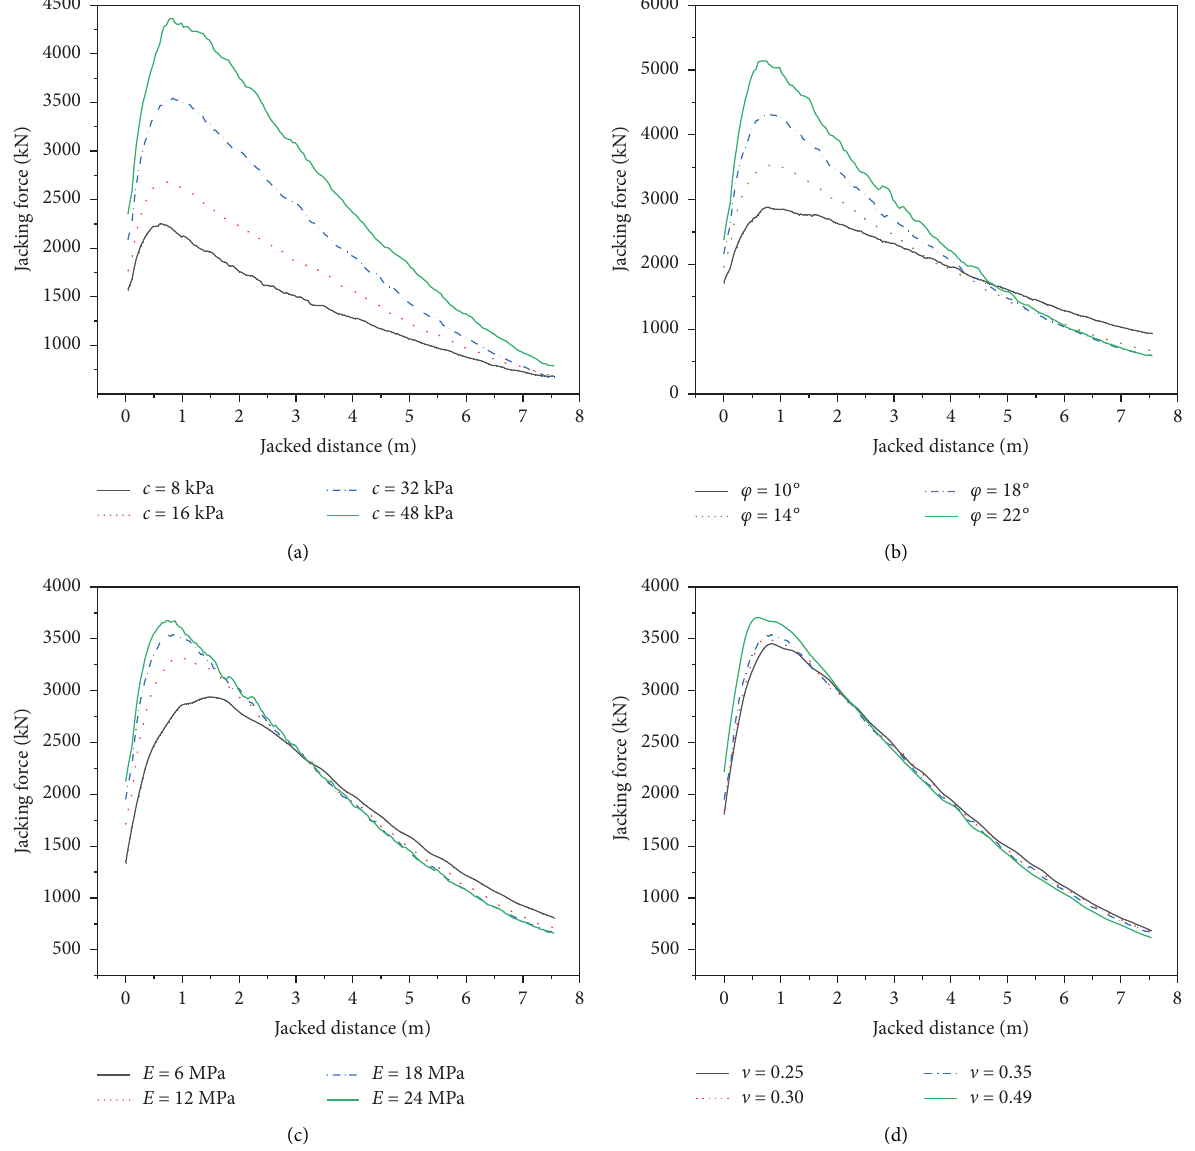
Figure 10: Infuence of soil conditions on jacking force. (a) Cohesion. (b) Internal friction. (c) Elastic modulus. (d) Poisson’s